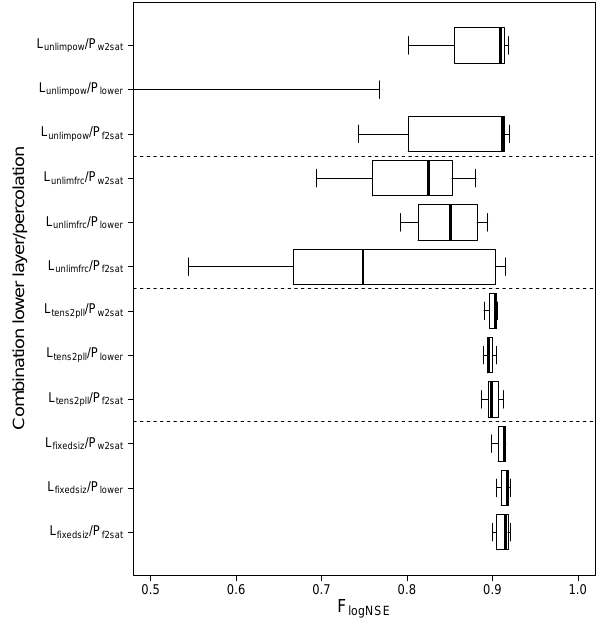
Fig. 4. Boxplots of the performance of models using different lower layer and percolation combinations. The box of models us- ing L unlimpow and P lower includes model performances ( F logNSE ) below zero.